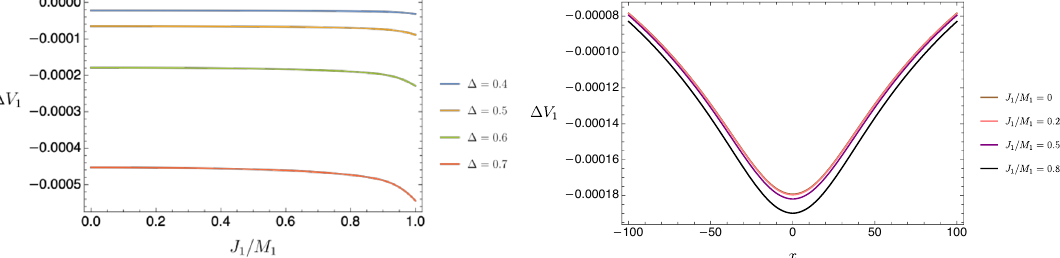
Figure 10. For the case of Gaussian coupling, the averaged null energy R and its profile for general x r − , 2 = 20 and r + , 1 = 100 , σ = 0 . 2 and x 0 = 0 . In the right panel we also choose ∆ = 0 . 6 .